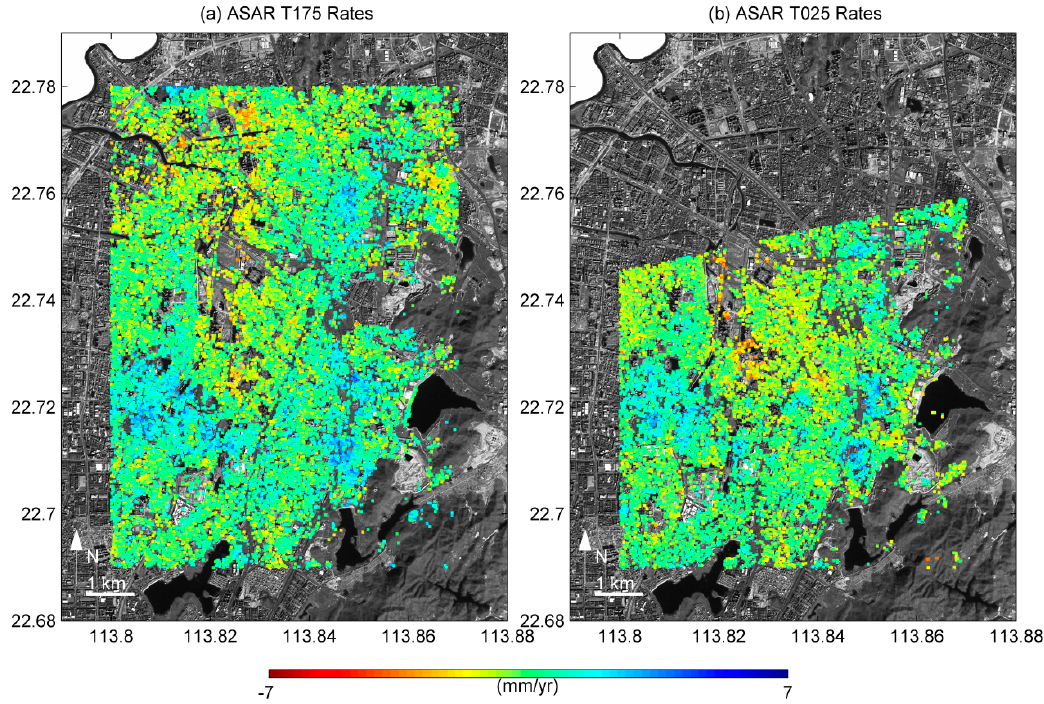
Figure 10. ( a ) CSK and ( b ) S1 mean rates in Shajing area.